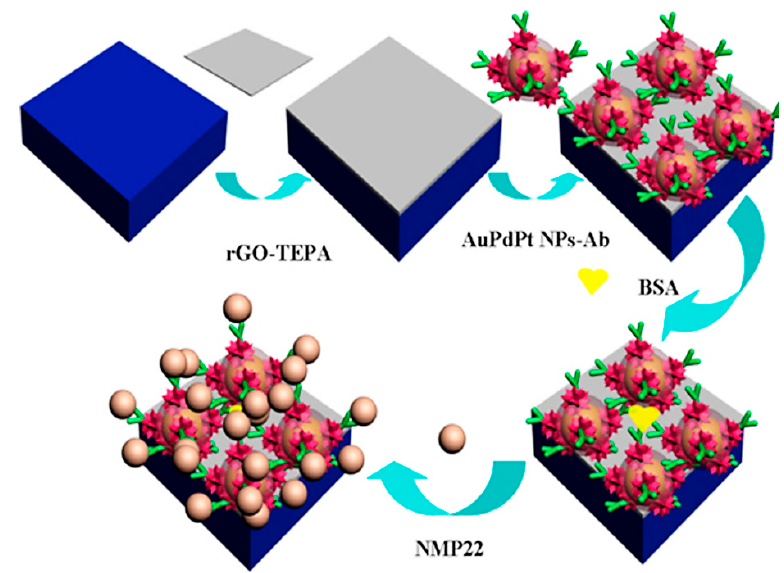
Figure 16. Schematic illustration of immunosensor for monitoring cancer biomarkers based on rGO-TEPA and trimetallic Au-Pd-Pt NPs. BSA: bovine serum albumin. Reproduced from [123], with permission from Elsevier, 2015.